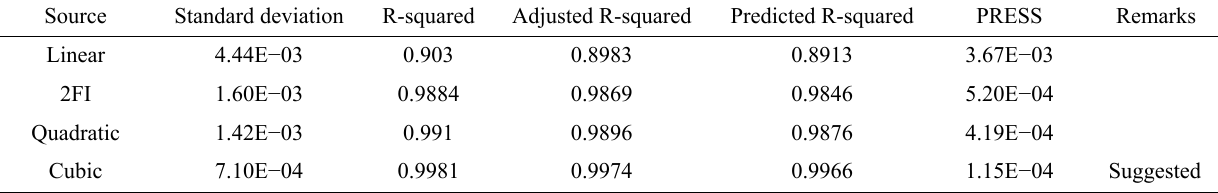
Table 8 R-Squared values for different models in the case of coefficient of